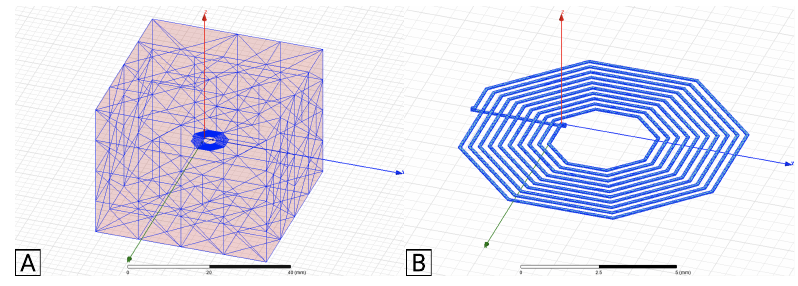
Figure 9. ( A ): Air box’s mesh. ( B ): Coil’s mesh. In Figures 10 and 11, the self-inductance results for the different 1-layer coil layouts (see Figure 5A–E) calculated using the different models are shown. Figure 10 presents inductance values for coils with 4 and 10 turns, with an inner segment of 0.3 mm, and space between turns and wire’s width of 0.15 mm.